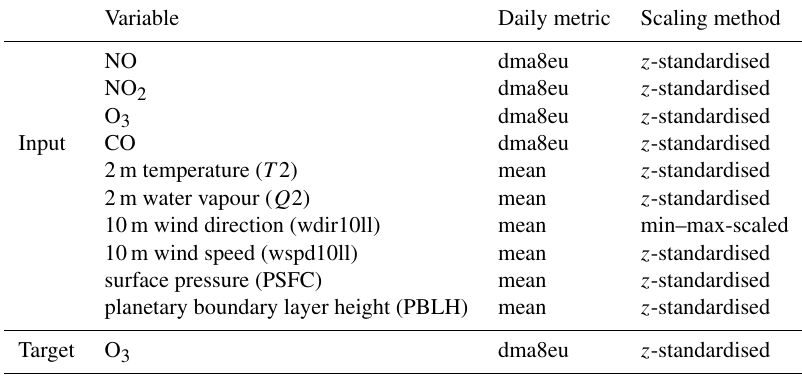
Table 2. Input and target variables with applied daily aggregation and scaling method. Variable Daily metric Scaling